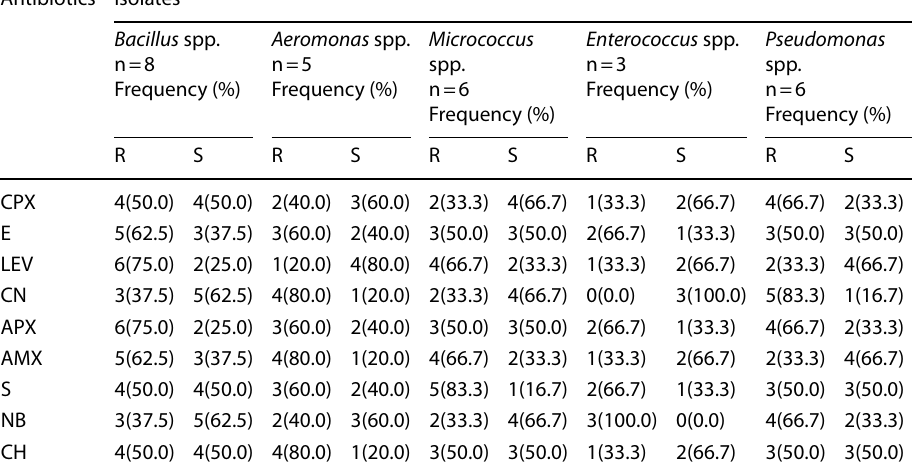
Table 2 Antibiotic susceptibility profile of microplastic degrading test